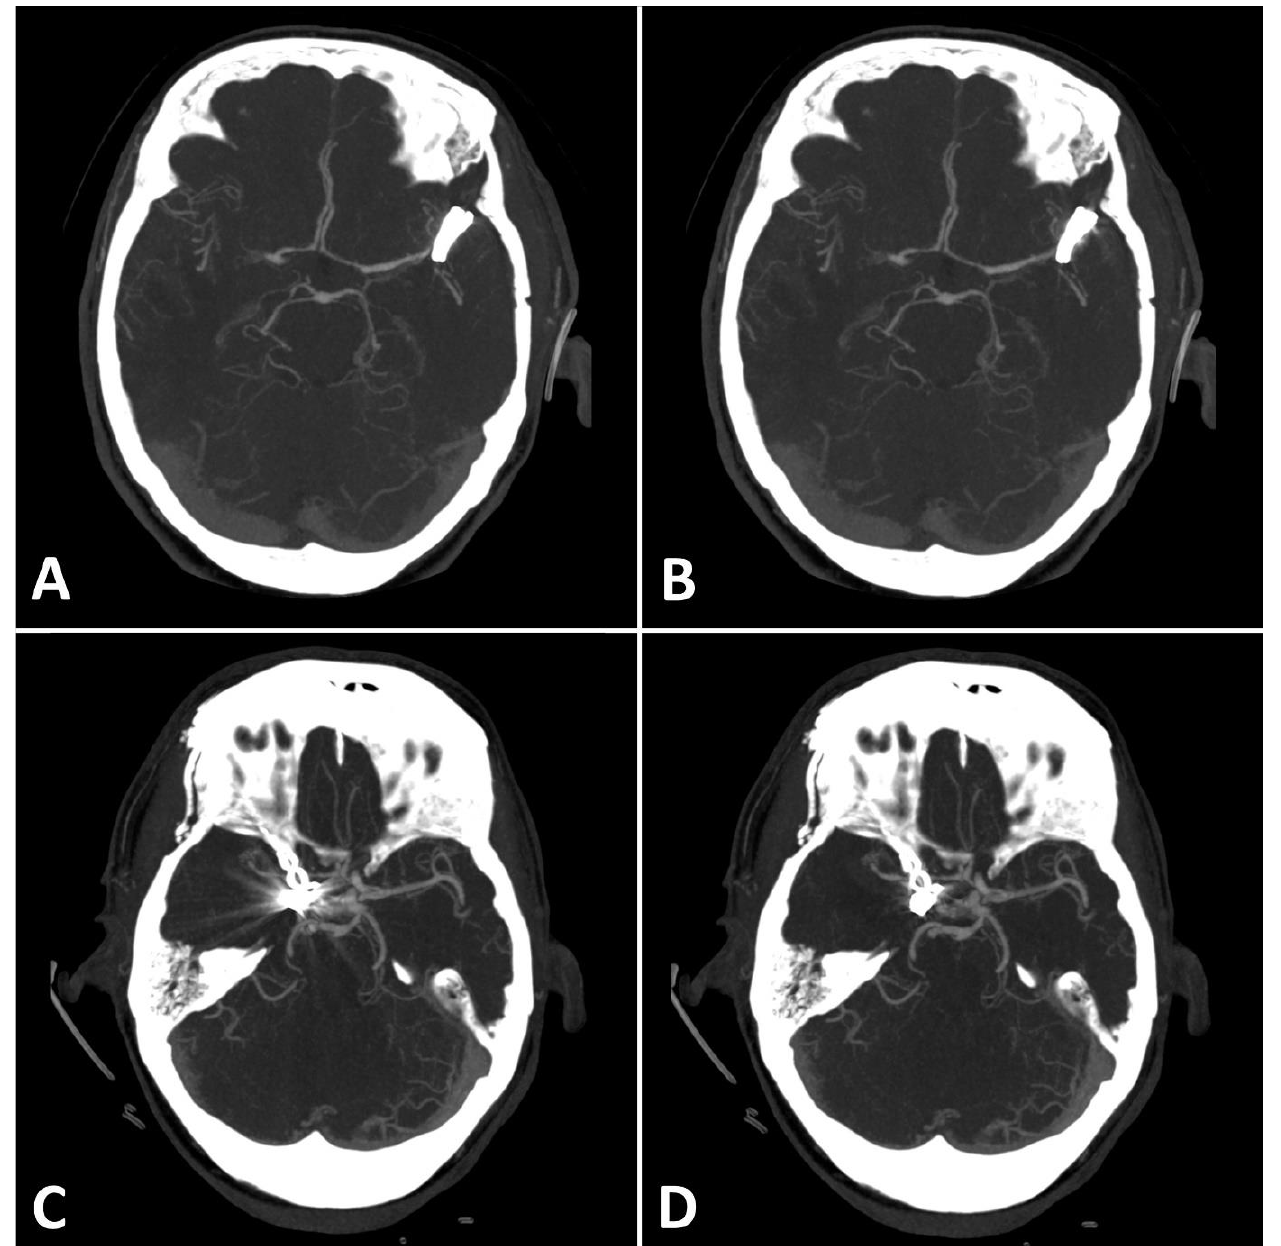
Figure 4. ( A , B ): Exemplary follow up UHR-CT-angiography in axial plane without ( A ) and with SEMAR ( B ) of a 74-year-old female with an intracranial clip in the left middle cerebral artery. ( C , D ): Exemplary follow up UHR-CT-angiography in axial plane without ( C ) and with SEMAR ( D ) of a 63-year-old female with an intracranial clip in the right internal carotid artery. All images were reconstructed as MIP (Maximum Intensity Projection) with 12.5 mm slice thickness and demonstrate the effects of SEMAR on images with clip-artifacts.